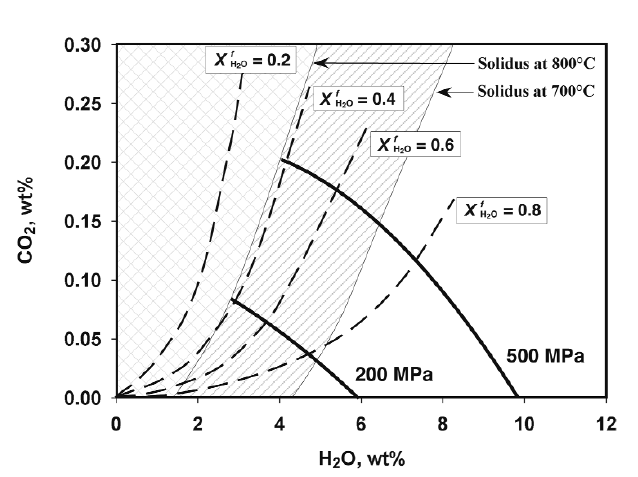
Fig. 7. Limitations for application of solubility models imposed by properties of rhyolitic systems. The curves of H 2 O-CO 2 solubility (thick solid lines) are from Tamic et al . (2001) obtained at 800°C. The hatched area rep- resents the subsolidus region of the eutectic composition in Ab-Or-Qz system at 800°C. In this field, water ac- tivity is too low for melts to be stable (100% crystallization). The solidus as a function of P and X f H has been drawn based on the data of Johannes and Holtz (1996). The area marked by the gray parallel lines and hatched area show the subsolidus field at